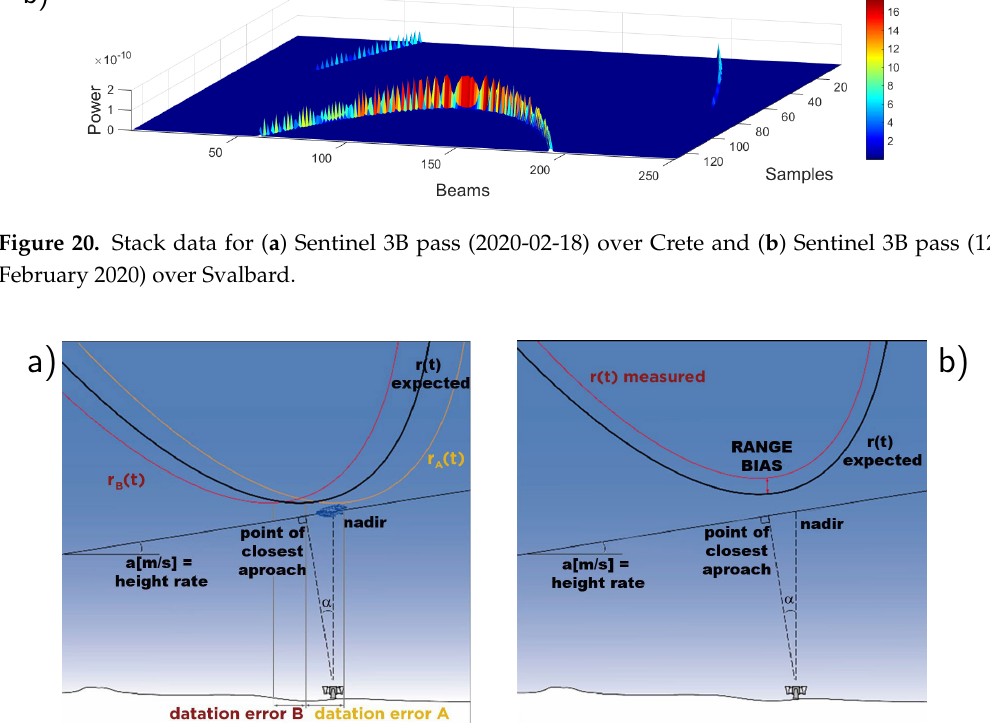
Figure 21. Schematic showing the effect of errors on the sequence of observed ranges (shown by the range vs. time parabolae). ( a ) An error in datation (timing of observations) means that the apex appears to occur at a different position along track. ( b ) An error in range results in a parabola nearer to or further away than expected from the point of closest